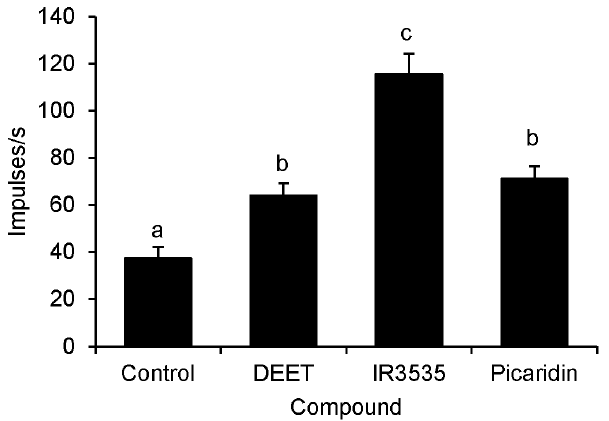
Figure 3. Total number of impulses per second produced in the interval 0.05–1.05 s after initial stimulation of the medial styloconic sensilla in L.dispar by the deterrent-sensitive neuron to 10 mM DEET, IR3535, and picaridin compared with the control (30 mM KCl in 10% ethanol). Different letters represent significant differences between groups. Vertical bars represent standard errors.